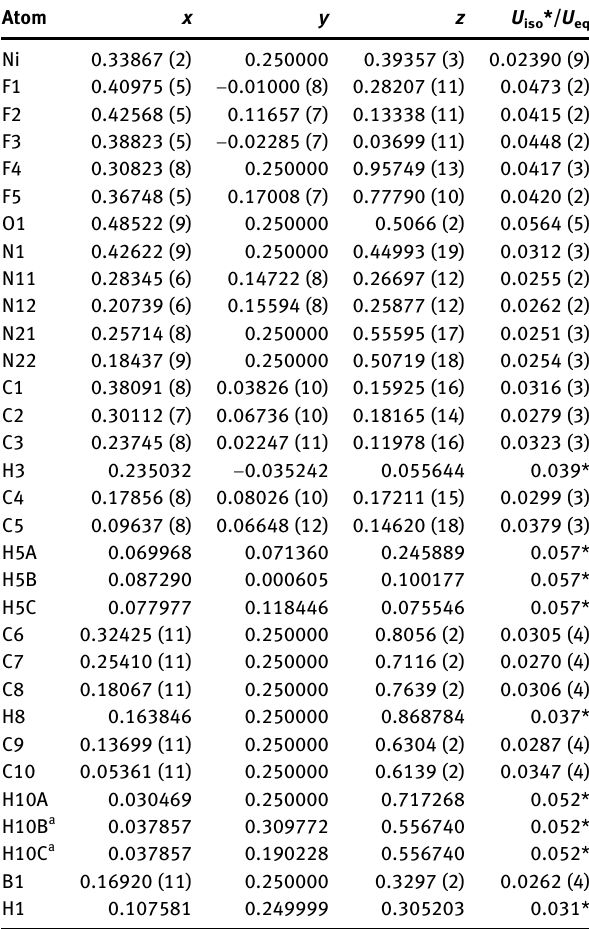
Table  : Fractional atomic coordinates and isotropic or equivalent isotropic displacement parameters (Å 